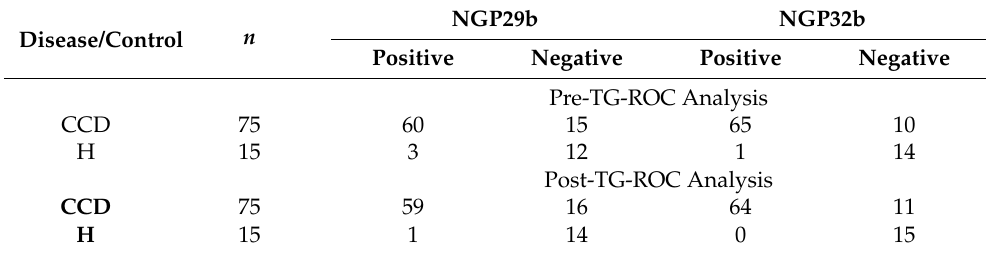
Table 1. CL-ELISA reactivity of sera from CCD patients and healthy individuals with NGP29b and NGP32b .